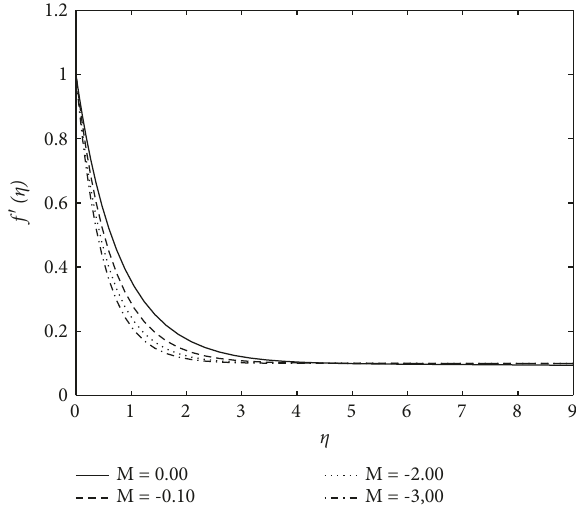
Figure 3: Change in the value of f ( η ) for different values of k . Figure 5: Change in the value of f ( η ) for different values of M . ′ ′ sheet. The velocity profiles for various values are depicted in Figure 2. The influence of the fluid parameter K on the velocity is seen in Figure 3. A rise in K can be interpreted as either a fall in viscosity or a decline in the Powell–Eyring thickness of the boundary layer are rising functions of K when λ <